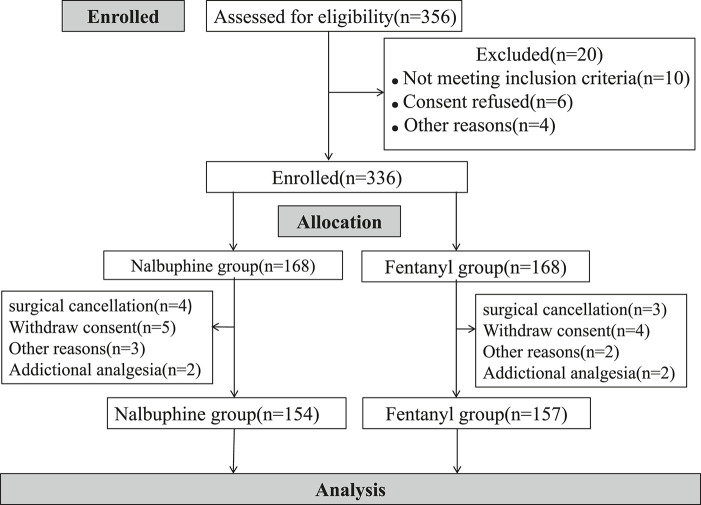
Patient disposition.